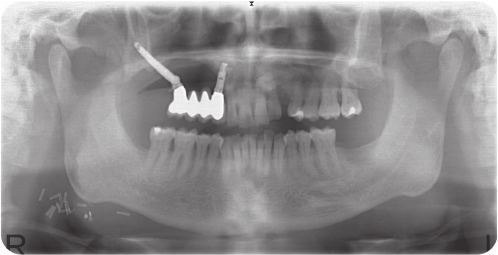
Figure 10: Radiographic view after 1 year